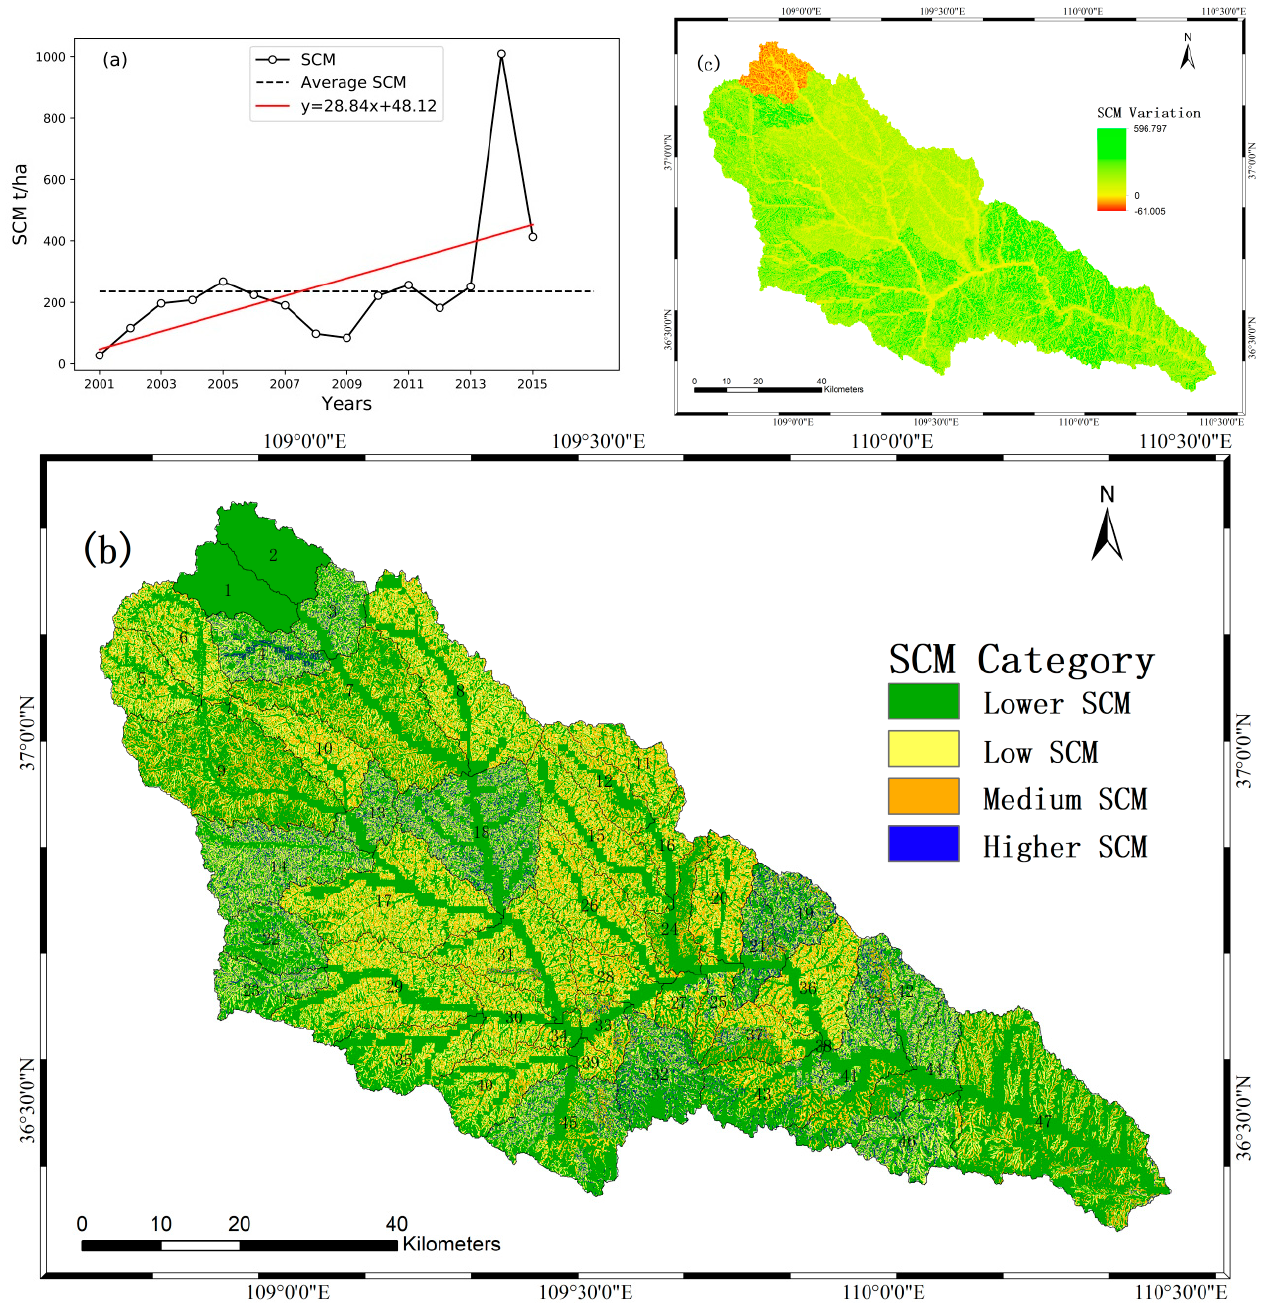
Figure 8. Soil conservation modulus (SCM) in the YanHe Watershed from 2000–2015: ( a ) Time series of annual average SCM; ( b ) Spatial distribution of multi-year average SCM categories; ( c ) SCM change trend.